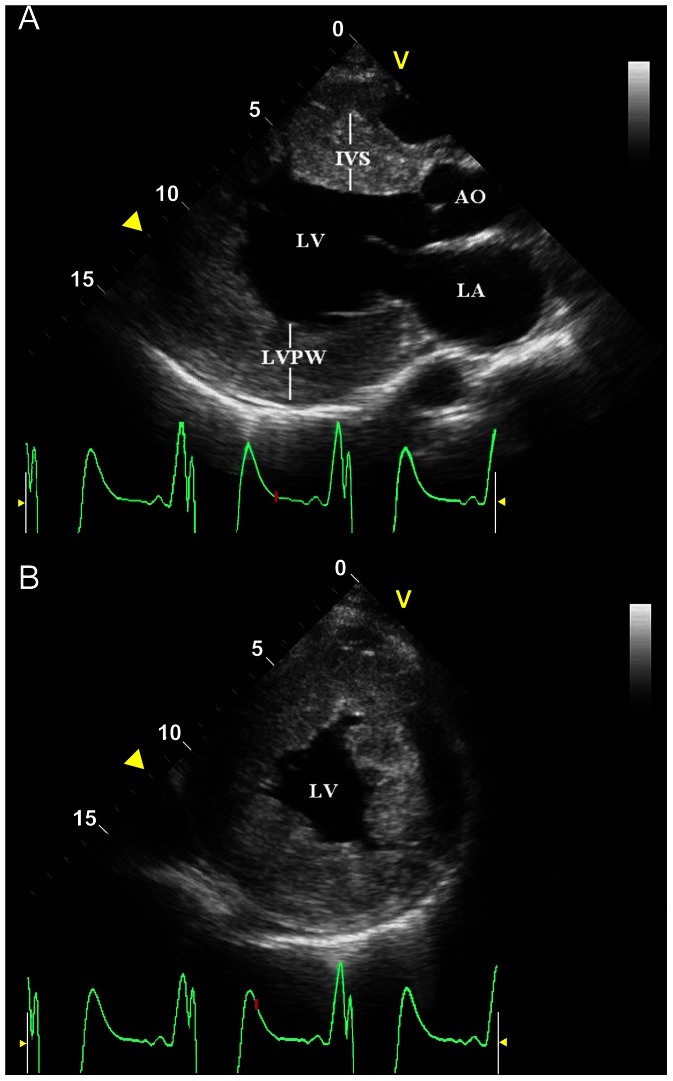
The parasternal long-axis view (A) and short-axis view (B) of an echocardiogram of the proband.It demonstrates severe concentric left ventricular (LV) hypertrophy with enlarged left chambers. AO, aorta; IVS, interventricular septum; LA, left atrium; LVPW: left ventricular posterior wall.